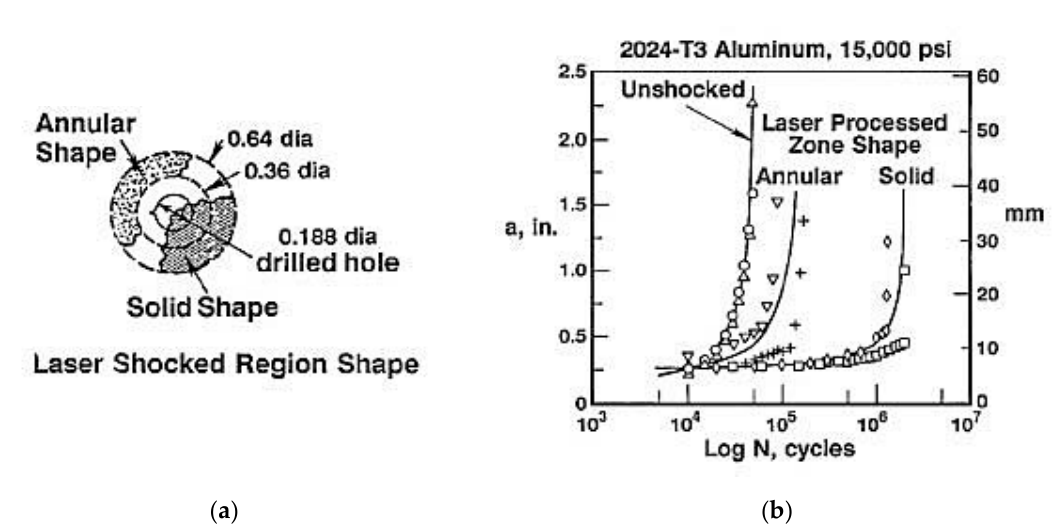
Figure 14. Crack propagation comparison for solid spot and annular spot laser shocking. The hole is 4.8 mm diameter. The annular beam has 9.1 mm ID and 16.3 mm OD; ( a ) annular spot application configuration; ( b ) crack growth comparison for shocked annular ring (15,000 psi = 103 MPa) [29].